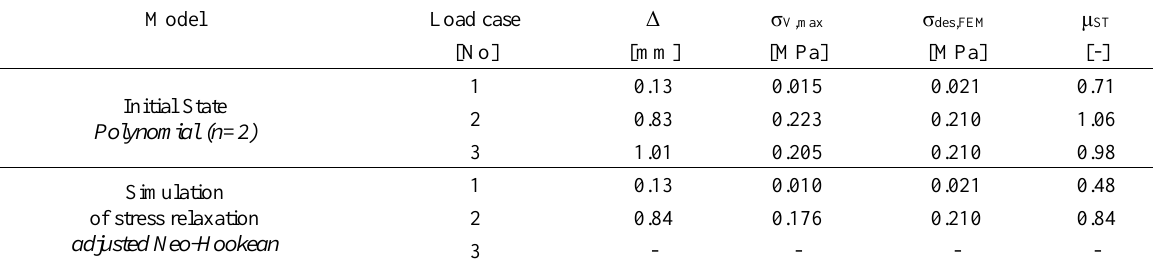
Table 4: Summary of the results of the finite element